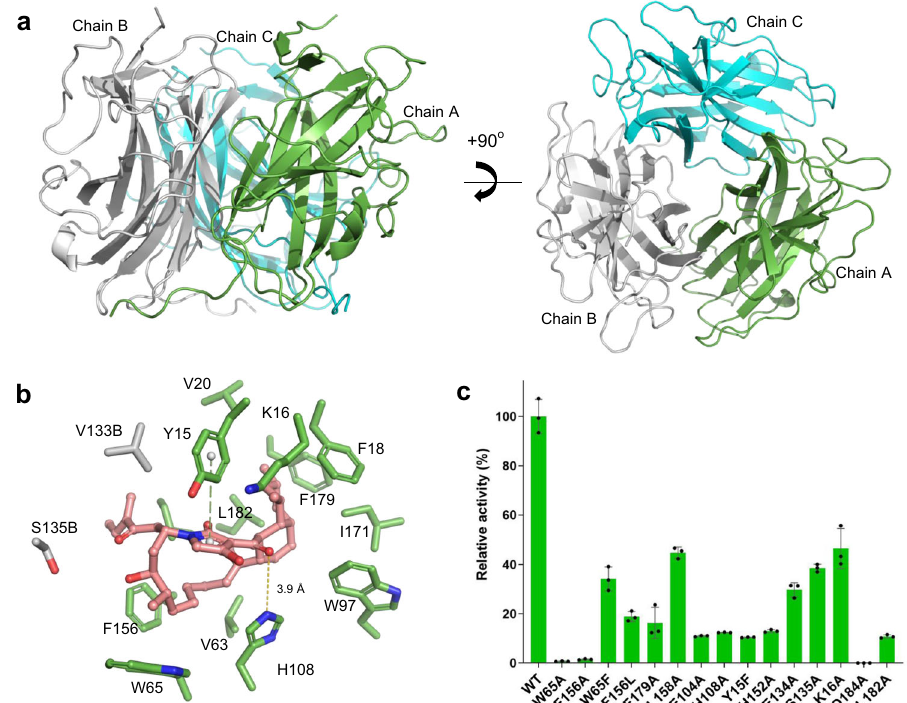
Fig. 3 | Crystal structures of AvmM. a Cartoon representations of the homo- trimeric AvmM. b Close-up active-site view of co-crystal structure of the AvmM active sitewith product 2 .Thehydrogen bondingand π – π stacking interaction are presentedbygolddashlineandgreendashline. c RelativeactivityofAvmMandits